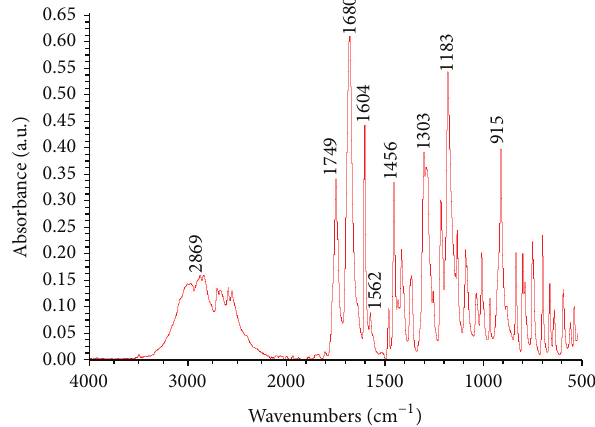
Figure 2: Infrared spectrum (4000–500 cm −1 ) of acetylsalicylic